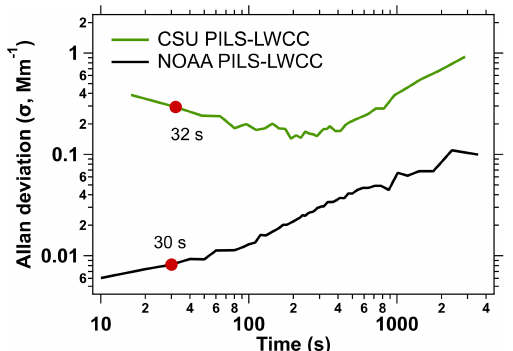
Figure 9. Allan deviation plot calculated for all WE-CAN data without plumes on Flight 10 (1:38h from 13 August 2018 19:16:29–20:54:58UTC) and FIREX-AQ NOAA Twin Otter flight data 11 August 2019 flight (2:03h from 11 August 2019 22:46:04– 12 August 2019 00:49:54UTC). There were no plumes during ei- ther of these periods. Data in red dots are used to determined the LOD for both systems.